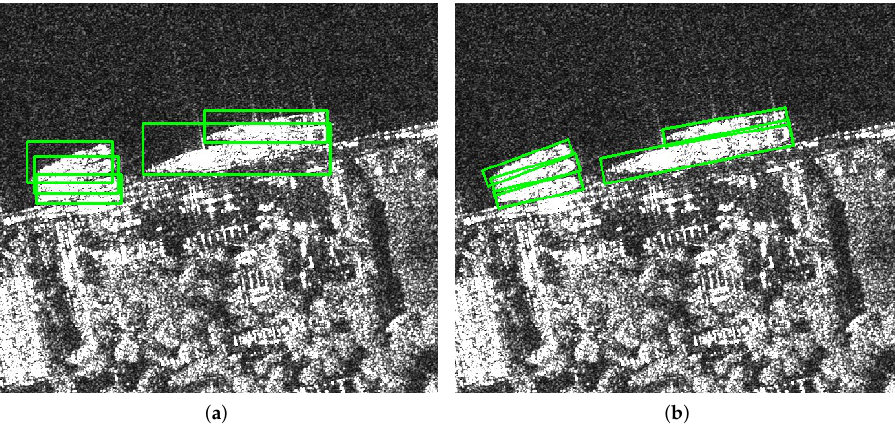
Figure 1. Example of ( a ) horizontal and ( b ) oriented bounding box of ships. Horizontal bound- ing boxes are heavily overlapped when targets are crowded and include much more irrelevant background areas than oriented bounding boxes. Image and the box labels are taken from the SSDD dataset